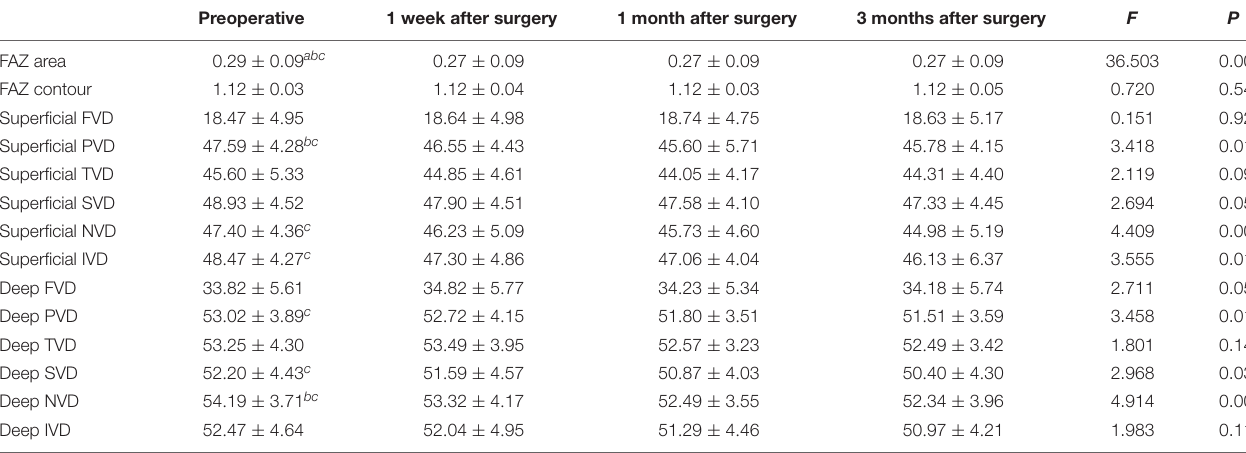
TABLE 3 | Changes of macular blood flow density at each time point.